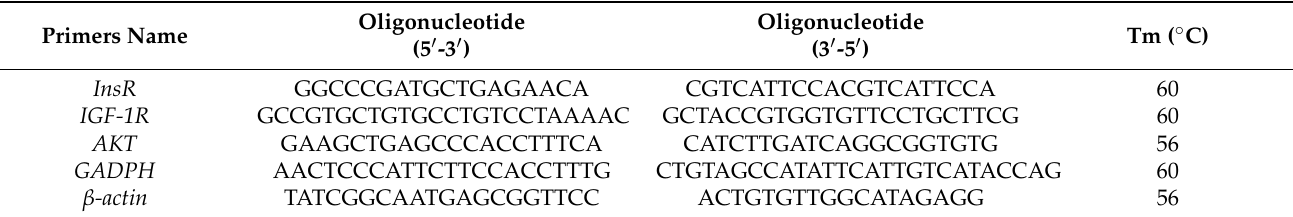
Table 1. Oligonucleotide primers used to amplify RNA